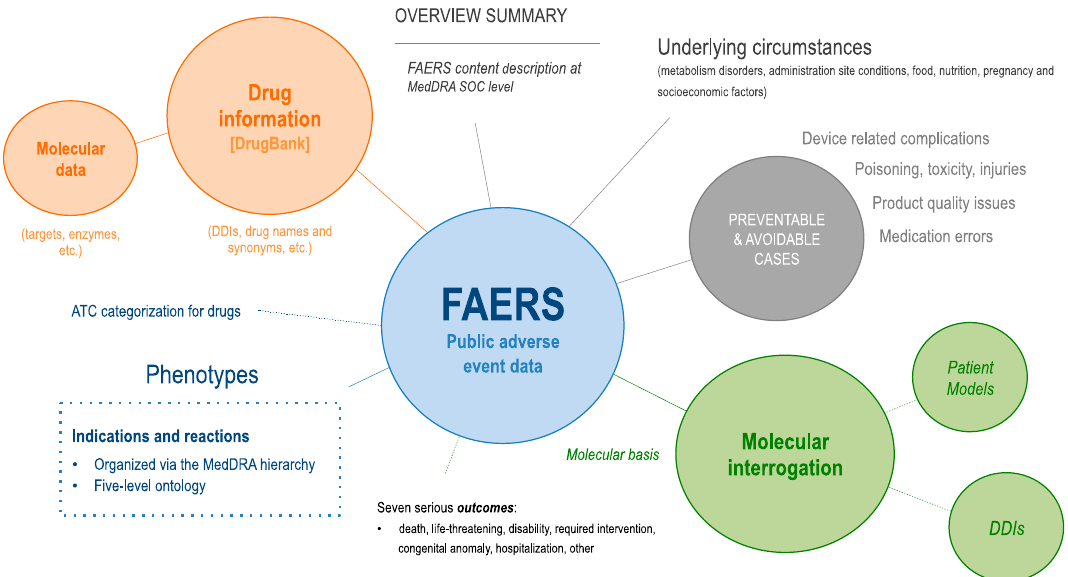
Figure 1. Synopsis of our Food and Drug Administration (FDA) Adverse Event Reporting System (FAERS) content study. First, we enriched FAERS data with DrugBank, Anatomical Therapeutic Chemical (ATC), and Medical Dictionary for Regulatory Activities (MedDRA) information. We then review the observed indication and reaction occurrence at different MedDRA terminology levels and finally examine molecular dependencies at the patient level and examine drug interaction rates.